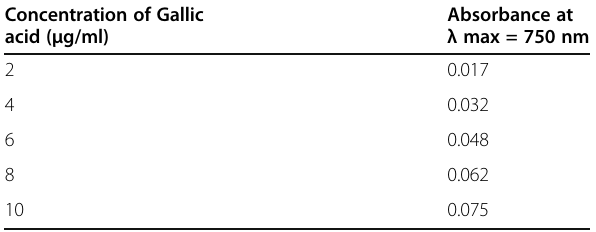
Table 3 Absorbance of Gallic acid equivalent at λ max = 750